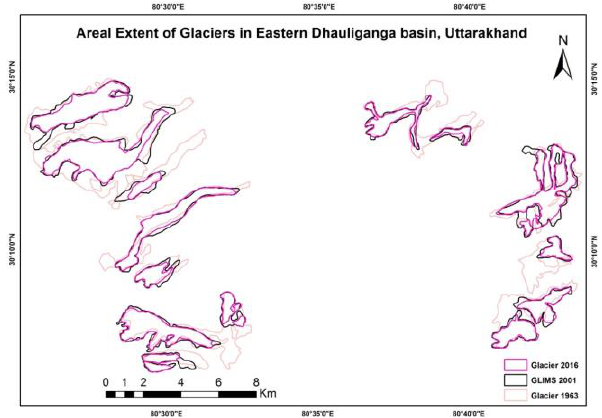
Figure 2. Glacier area change from 1963-2016. Glacier outlines are mapped from Survey of India toposheet (1963), GLIMS boundary (2001) and Landsat 8 OLI image of raw DNs.